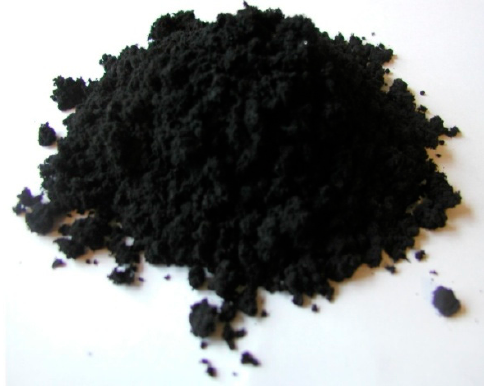
Figure 1. Photograph of multi-walled carbon nanotubes (MWCNTs) powder obtained by mechanical grinding of macro cylinders with walls consisting of radially oriented MWCNTs.